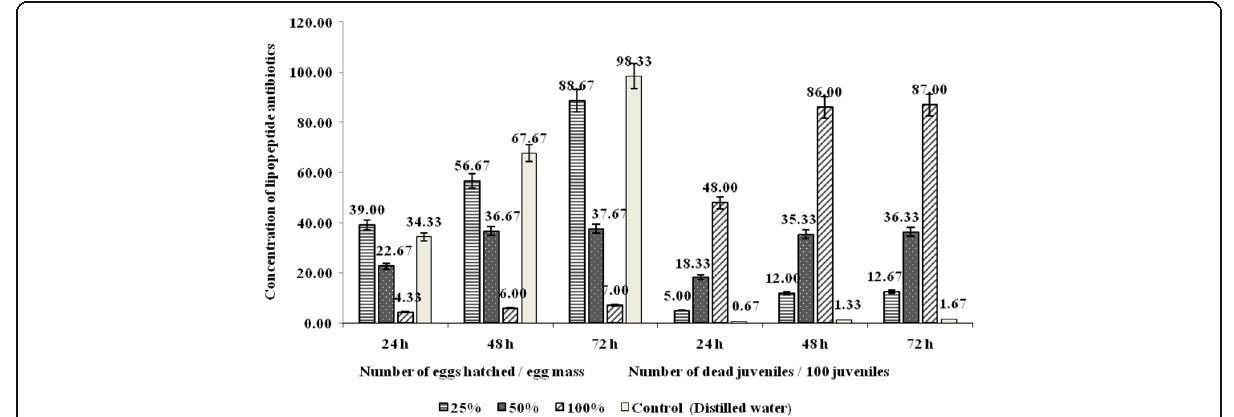
Fig. 5 Bioassay of crude antibiotic on egg hatching and juvenile mortality of M.